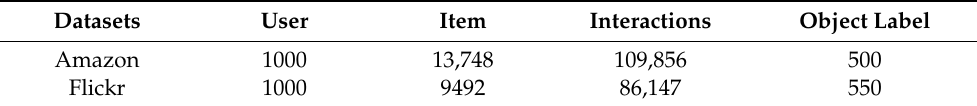
Table 4. Description of the processed datasets.